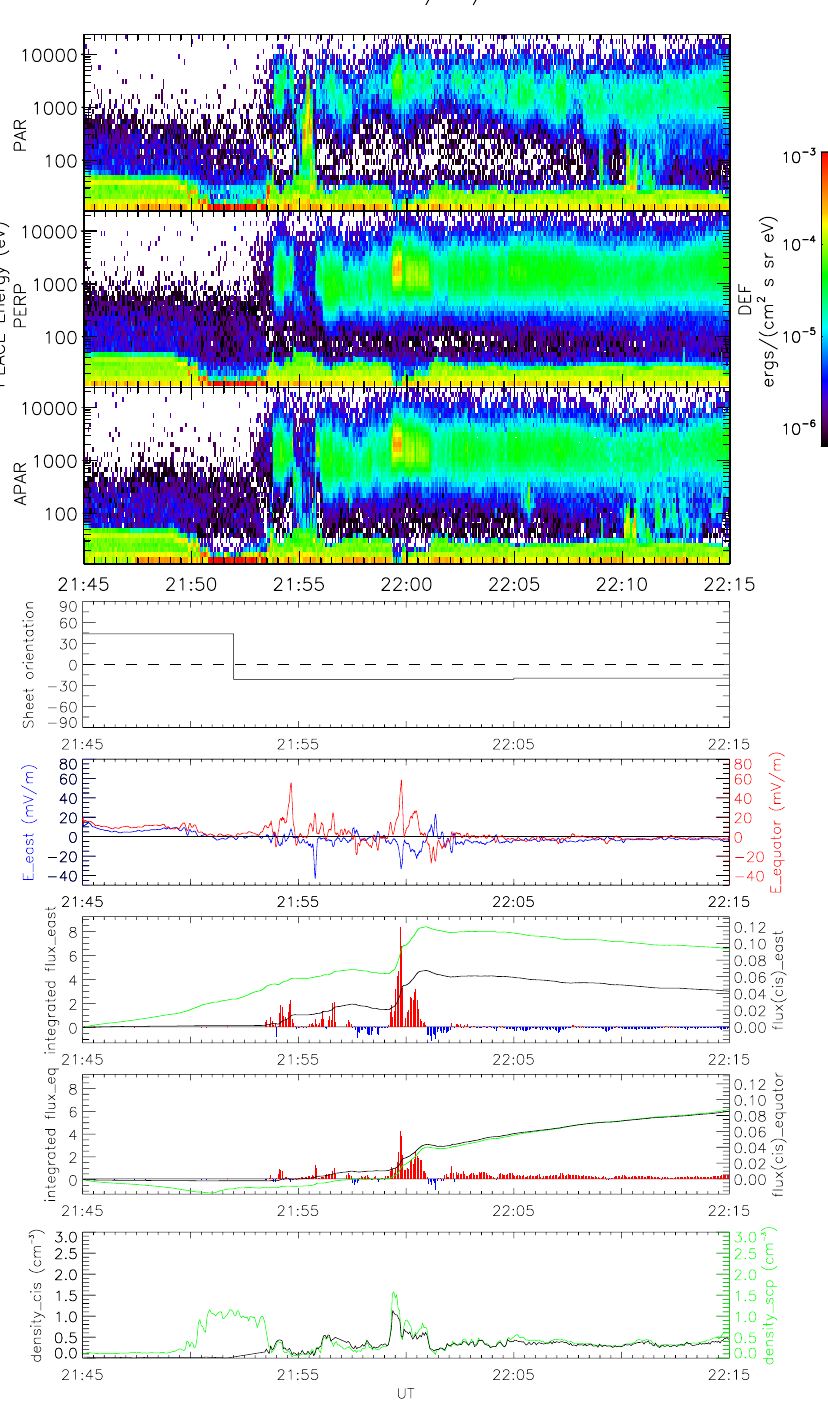
Fig. 1. Measurements by Cluster spacecraft 4 from a southern auroral oval crossing on 15 April 2002. The first three panels are electron energy-time spectrograms, displaying the energy flux in parallel, perpendicular and anti-parallel to the B-field. Panel 4 shows the direction of the sheet orthogonal to the strongest E-field variation. Panel 4 shows the eastward (blue) and equatorward (red) components of the E-field. Panels 5 and 6 show the plasma flux, calculated from CIS density data. The black (green) curve is the integrated flux, using CIS density measurements (density derived from spacecraft potential). The last panel shows the CIS density measurements (black), and the density derived from the spacecraft potential